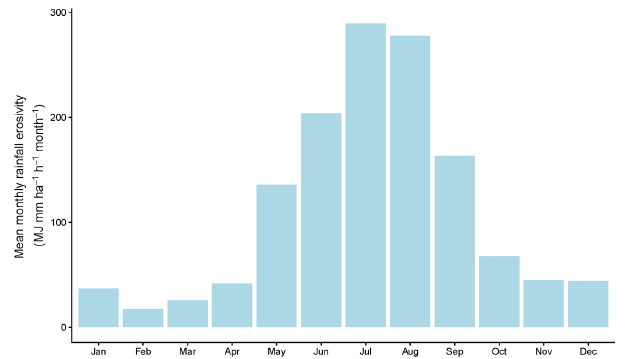
Figure 2. Mean monthly rainfall erosivity for all 87 Swiss